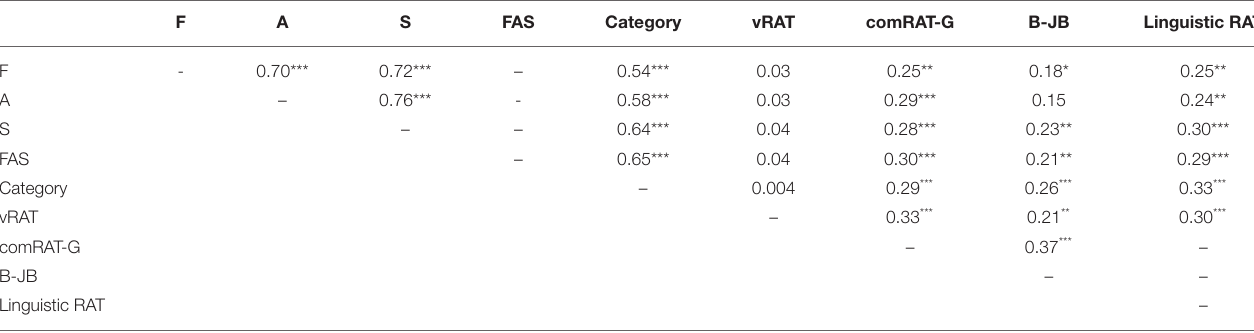
TABLE 4 | Correlations between all scoring and accuracy metrics for all the participants of Study-2.